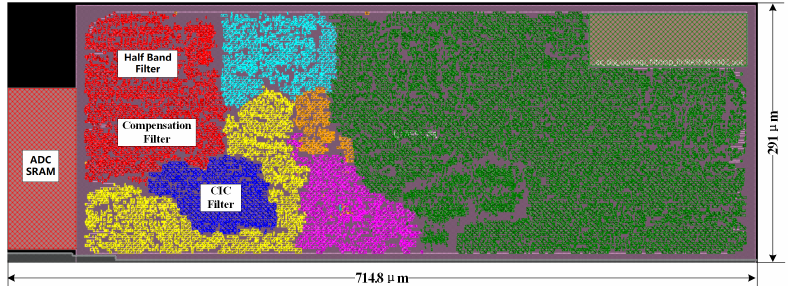
Figure 11. Layout of the digital decimation